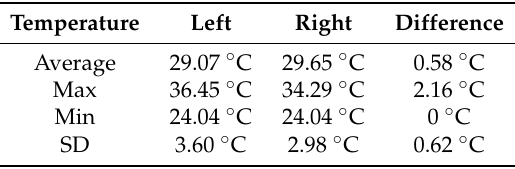
Figure 17. Case 2: ( a ) original acquired thermogram; ( b , c ) lower limit detection; ( d ) second degree polynomials; ( e ) right; and ( f ) left segmented breasts. Table 5. Statistical values of the temperatures of the segmented left and right breast areas and difference estimation for Case